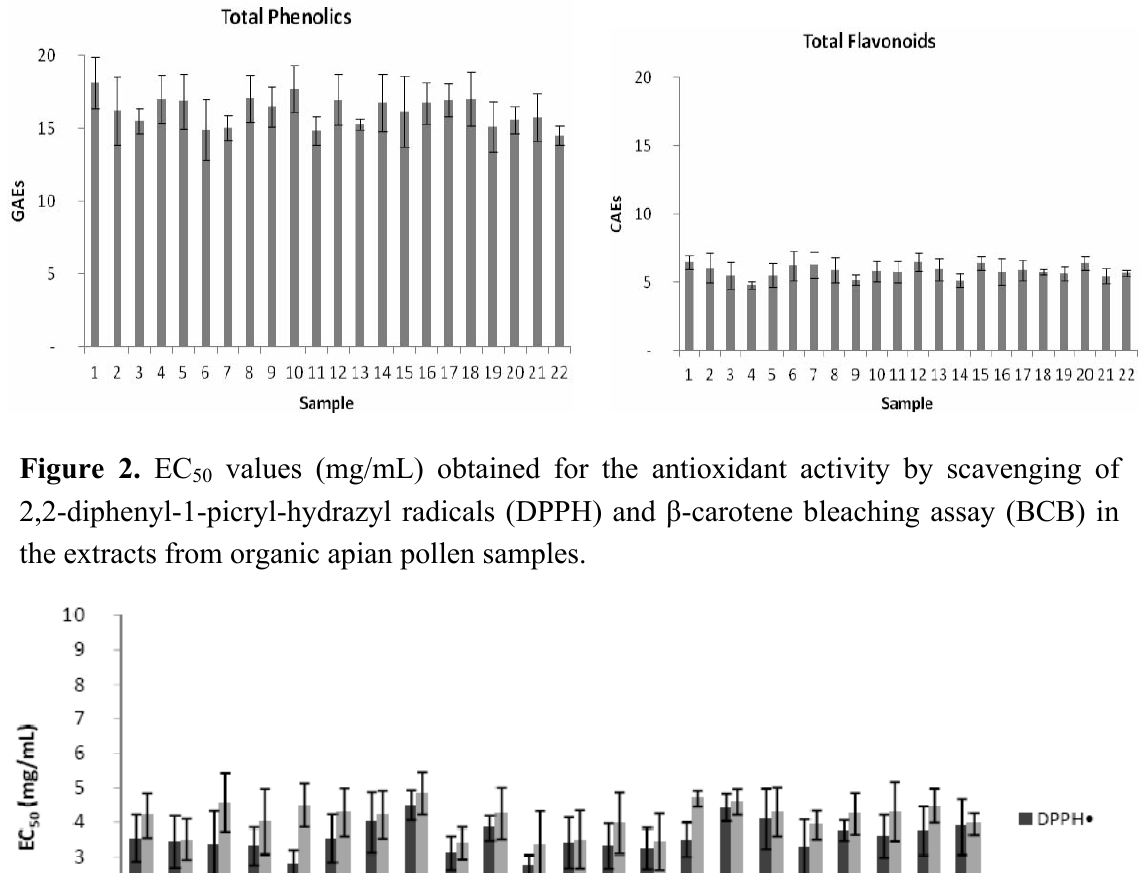
Figure 1. Total phenolics [TPC; in mg of gallic acid equivalents per g of organic apian pollen extract (GAEs)] and total flavonoids [TFC; in mg of catechin equivalents per g of organic bee pollen extract (CAEs)] of the analyzed samples.